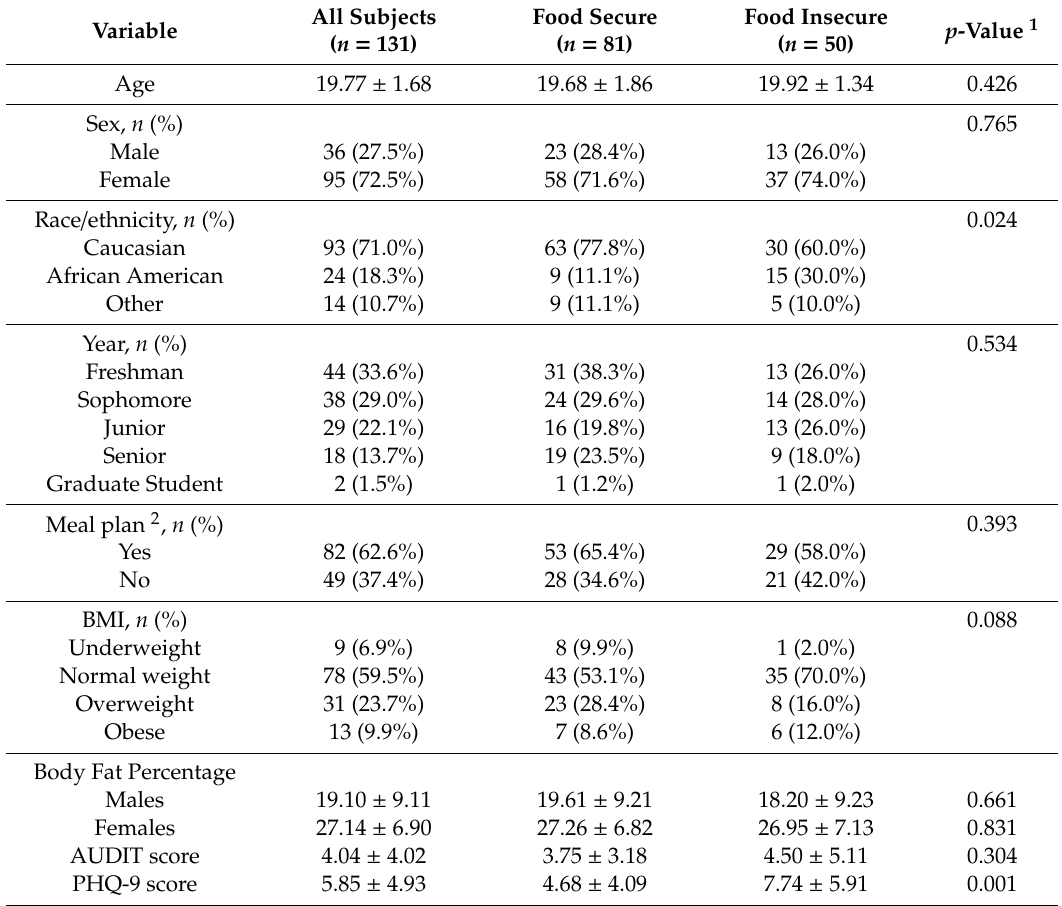
Table 1. Characteristics of the Study Group and Correlations with Food Security